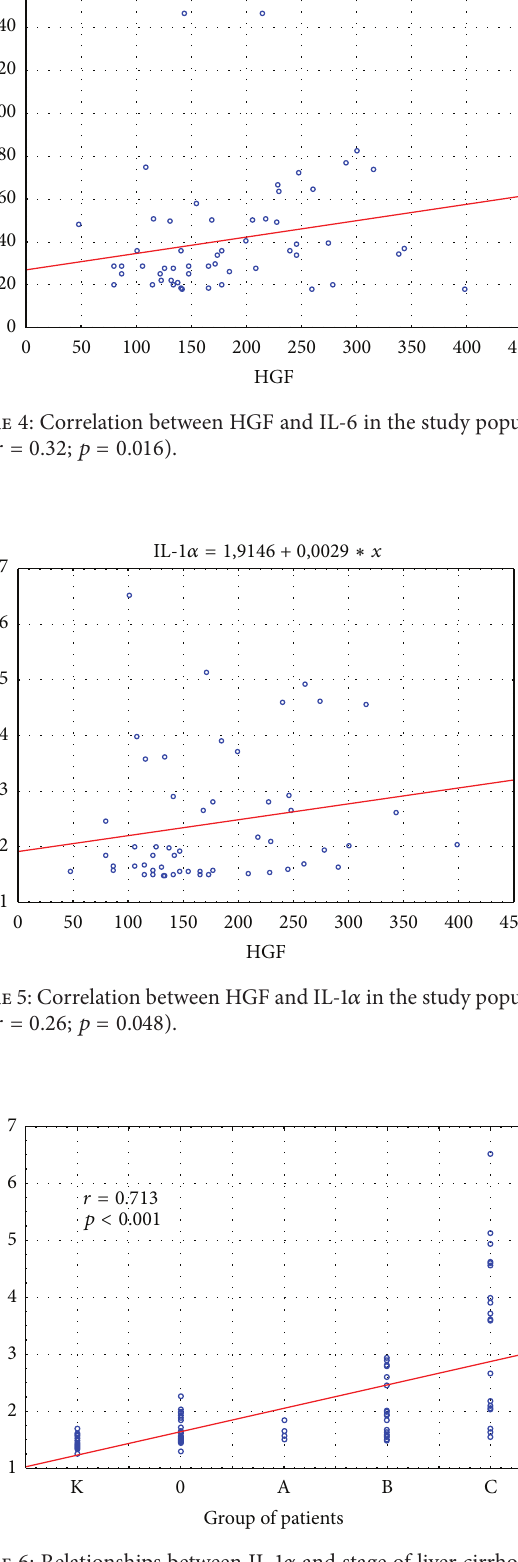
Figure 6: Relationships between IL-1 𝛼 and stage of liver cirrhosis. Key: 0: alcoholics without liver cirrhosis; A, B, and C: alcoholics with liver cirrhosis Pugh-Child stages A–C; K: healthy controls.